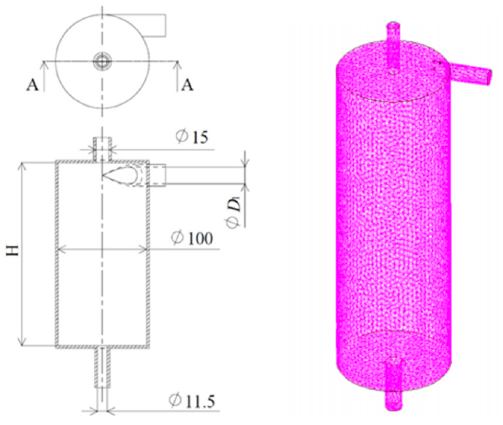
Figure 3. Schematic diagram and mesh arrangement of the oil tank.